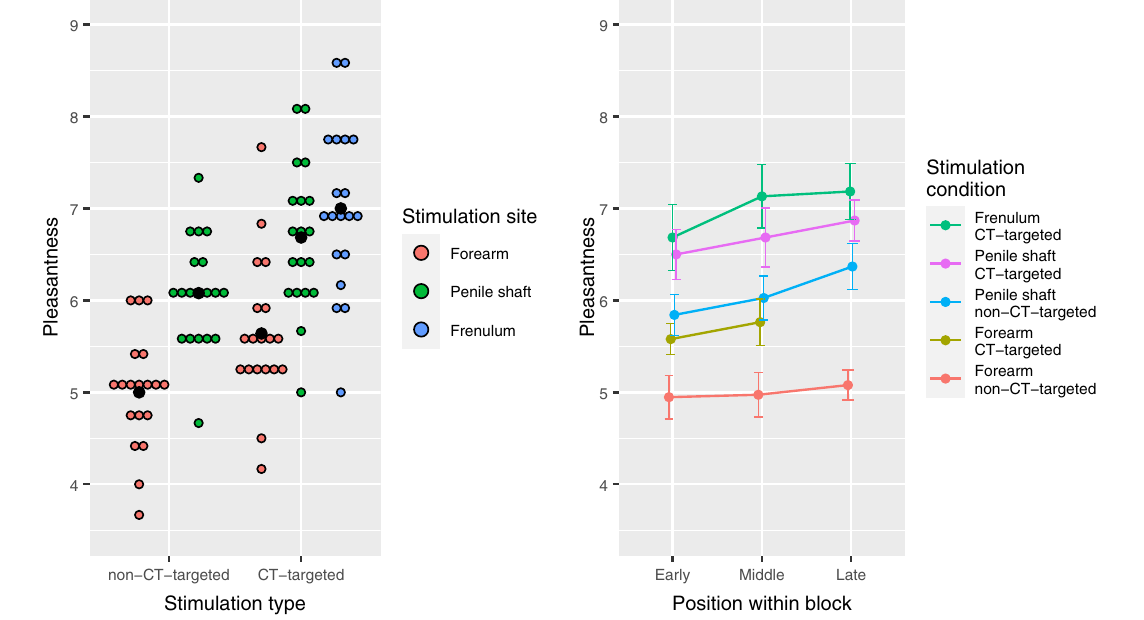
Figure 1. Overview of mean pleasantness scores (N = 19) per dynamic touch condition. Ratings were given on a scale from 0 (‘very unpleasant’) to 10 (‘very pleasant’). Left panel: The scores show a linear pattern where penile shaft stimulation was preferred over forearm stimulation ( p < 0.0001) and CT-targeted stimulation was preferred over non-CT-targeted stimulation ( p < 0.0001). There was no significant interaction between stimulus type and stimulus site. Coloured dots indicate individual participant means and black dots indicate the group mean. Right panel: Pleasure ratings for all stimulation types were also influenced by the position within a stimulation block. A later (vs. earlier) position within a stimulation block enhanced perceived pleasure in a linear way ( p < 0.001). In this panel, data points are averaged over subjects and sessions, and error bars indicate 95% confidence intervals. Figures were created using ggplot2 (v. 3.3.2; https:// ggplo t2. tidyv erse. org/ ) within RStudio (v. 1.4.1106; https:// www. rstud io.